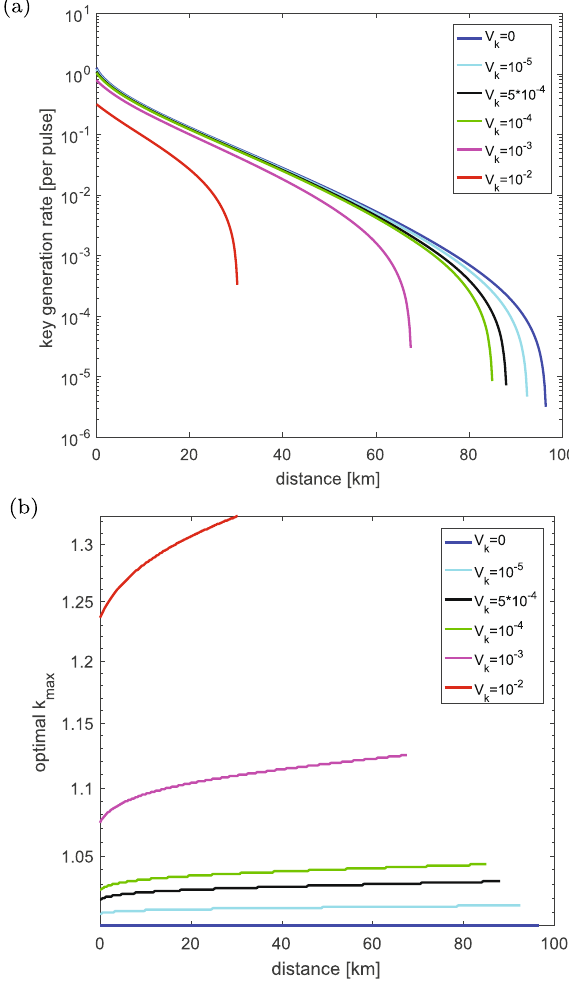
Fig. 8 Optimization for case (2B) with Gaussian distribution. Here, for uniform distribution. a we optimize the secret key rate R R 2 B Optimal secret key rate versus transmission distance for different uniform distribution. b Optimal k max versus transmission distance for different uniform for 2 B